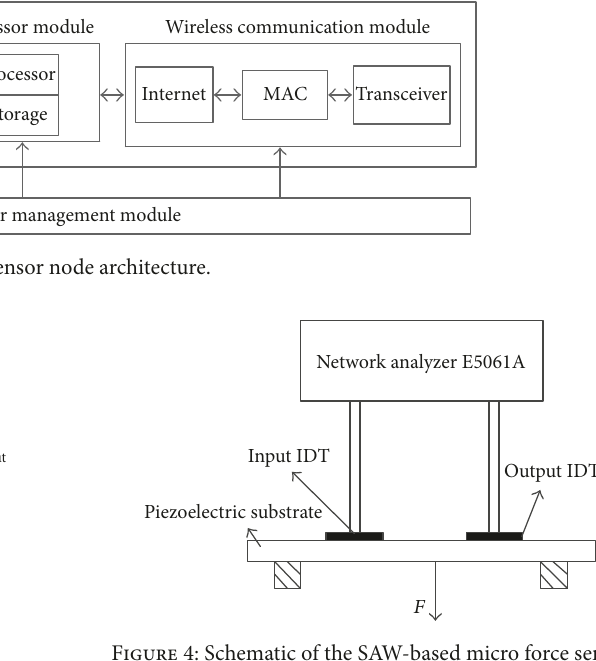
Figure 4: Schematic of the SAW-based micro force